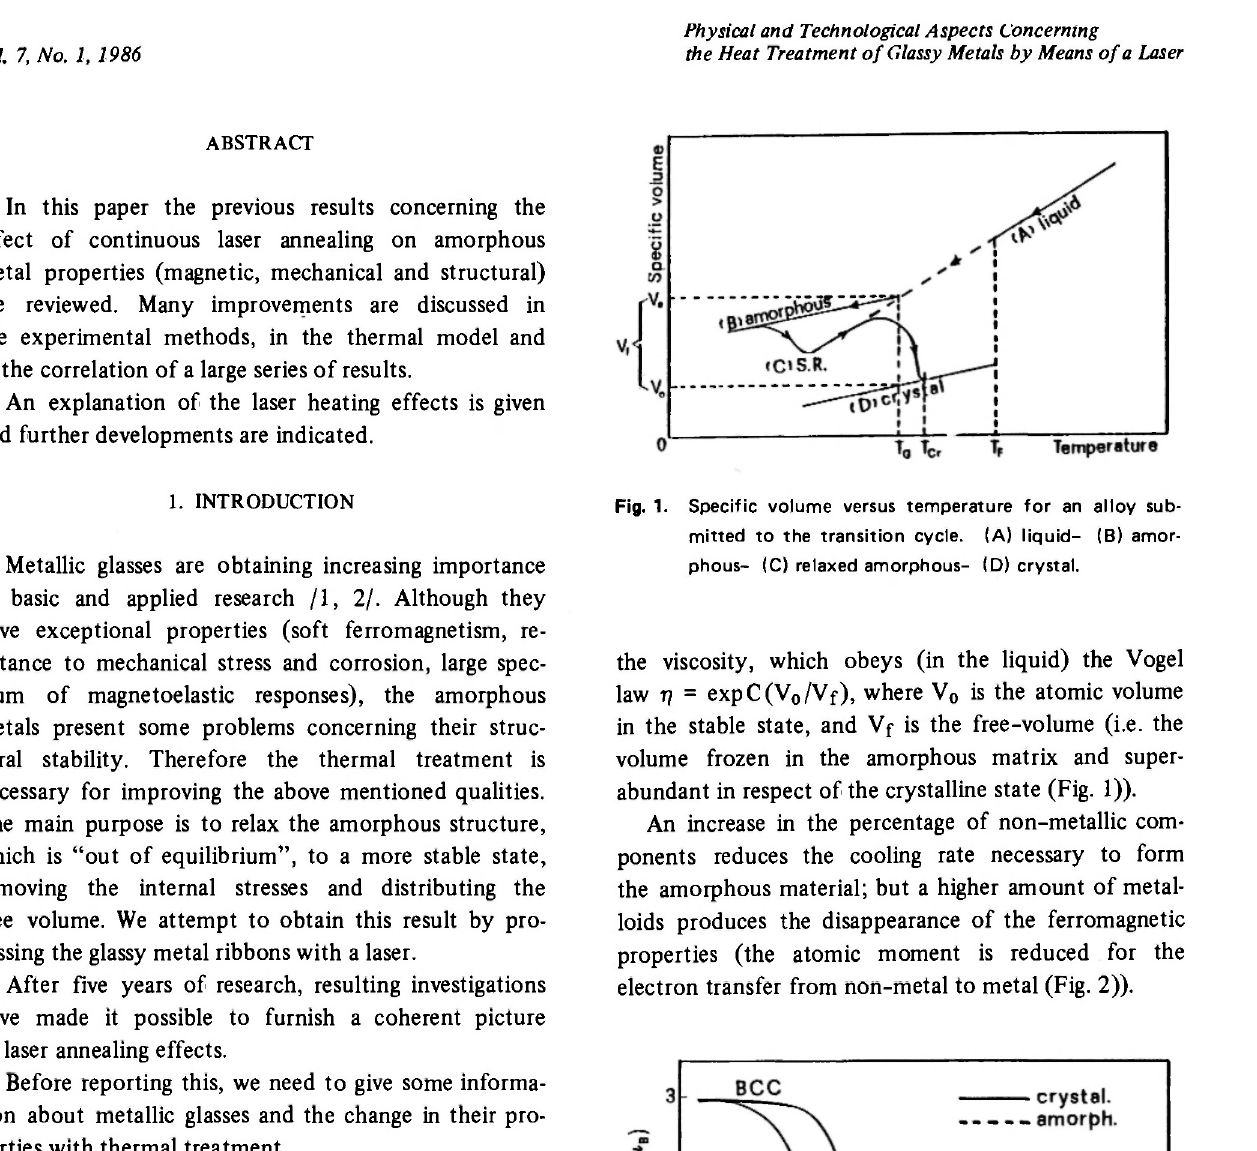
Fig. 2. Reduction of atomic moment due to the increase of the 3d +4s electrons when metals are alloyed with